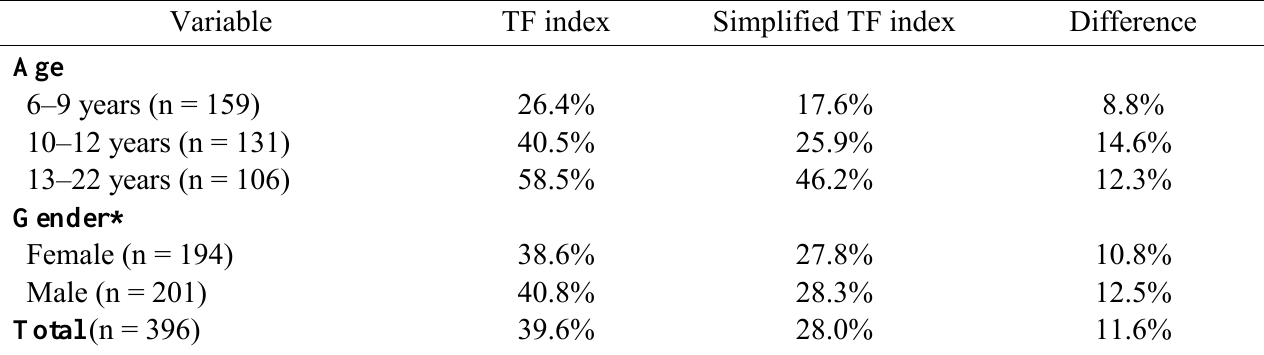
Table 5. Prevalence of severe fluorosis (TF index ≥ 5) according to age and gender using the full mouth TF index and simplified TF index, rural communities, Brazil.